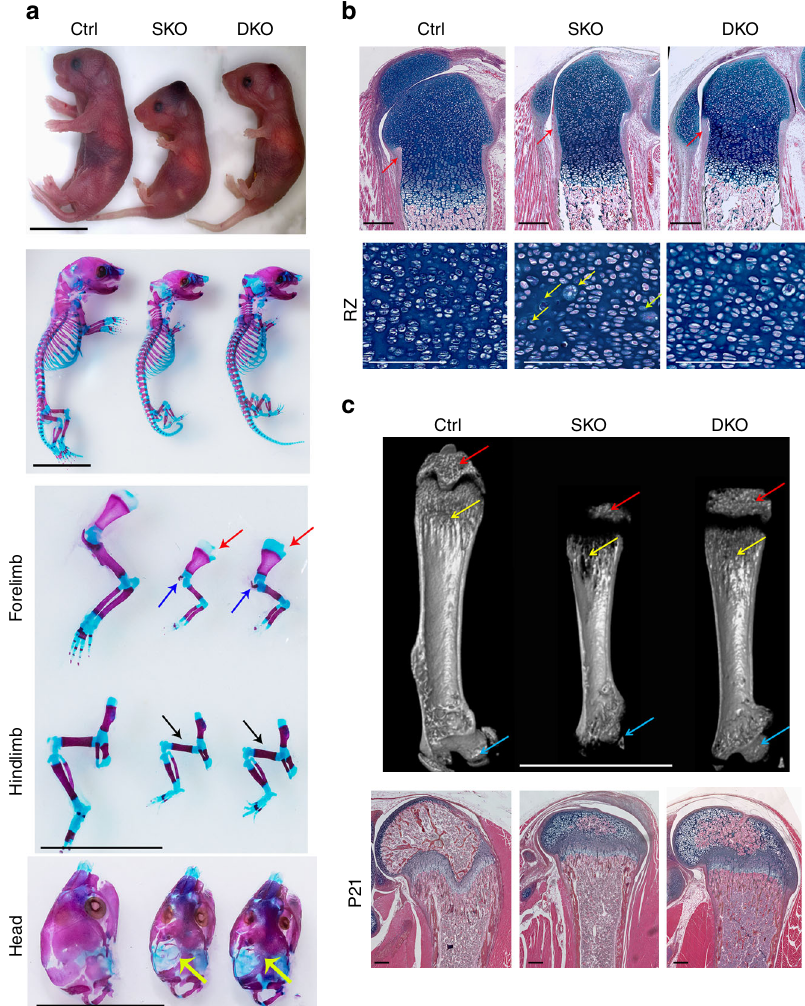
Fig. 6 Trp53 knockout partially rescued skeletal defects caused by Senp6 loss. a Prx1-Cre;Senp6 f/f ;Trp53 f/f (DKO) P0 mice had a partially rescued skeletal phenotype relative to Prx1-Cre;Senp6 f/f ;Trp53 f/ + (SKO) mice, as suggested by the smaller indentation in the scapula growth plate (red arrows), the longer clavicles (blue arrows), increased width and length of the femur (black arrows), tibia, humerus, ulna, and radius, and the moderately increased mineralization in the cranial bones (yellow arrows). Scale bars = 1 cm. b P0 DKO femoral sections show corrected growth plate diameter, perichondrium thickness (red arrows), and chondrocyte size (yellow arrows) relative to those of SKO mice. Scale bars = 100 μ m for the upper panels and 50 μ m for the lower panels. c p53 loss partially corrected the low bone mass and the delayed SOC formation of SKO mice at P21 as revealed by microCT imaging (SOC, red arrows; metaphasis bone, yellow arrows; proximal femur head, blue arrows; scale bars = 1 cm). H&E staining of the corresponding femurs is shown in the lower panels; scale bar = 100 μ